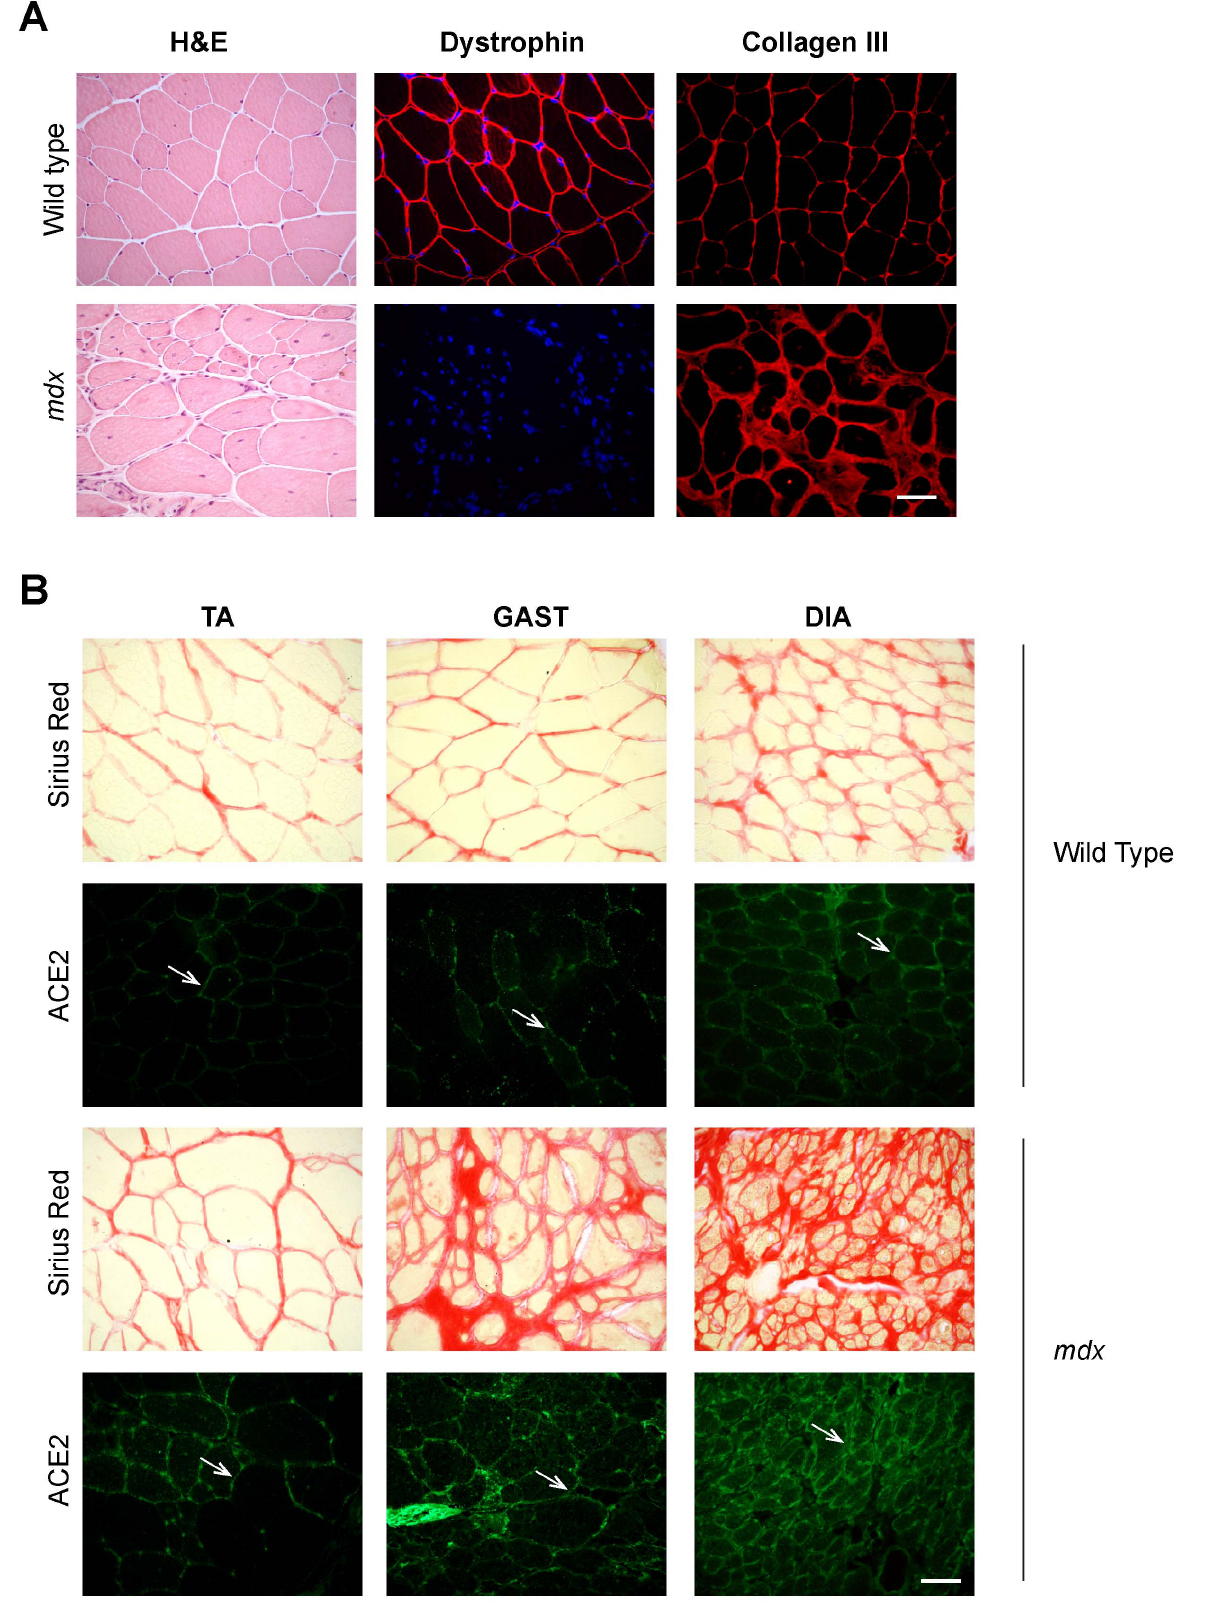
Figure 2. Levels of ACE2 in different skeletal muscle correlate with the degree of fibrosis. (A) Left panels, hematoxylin and eosin (H&E) staining of wt and mdx GAST cross-sections; middle panels, immunodetection of dystrophin in GAST; right panels, detection of collagen III by indirect